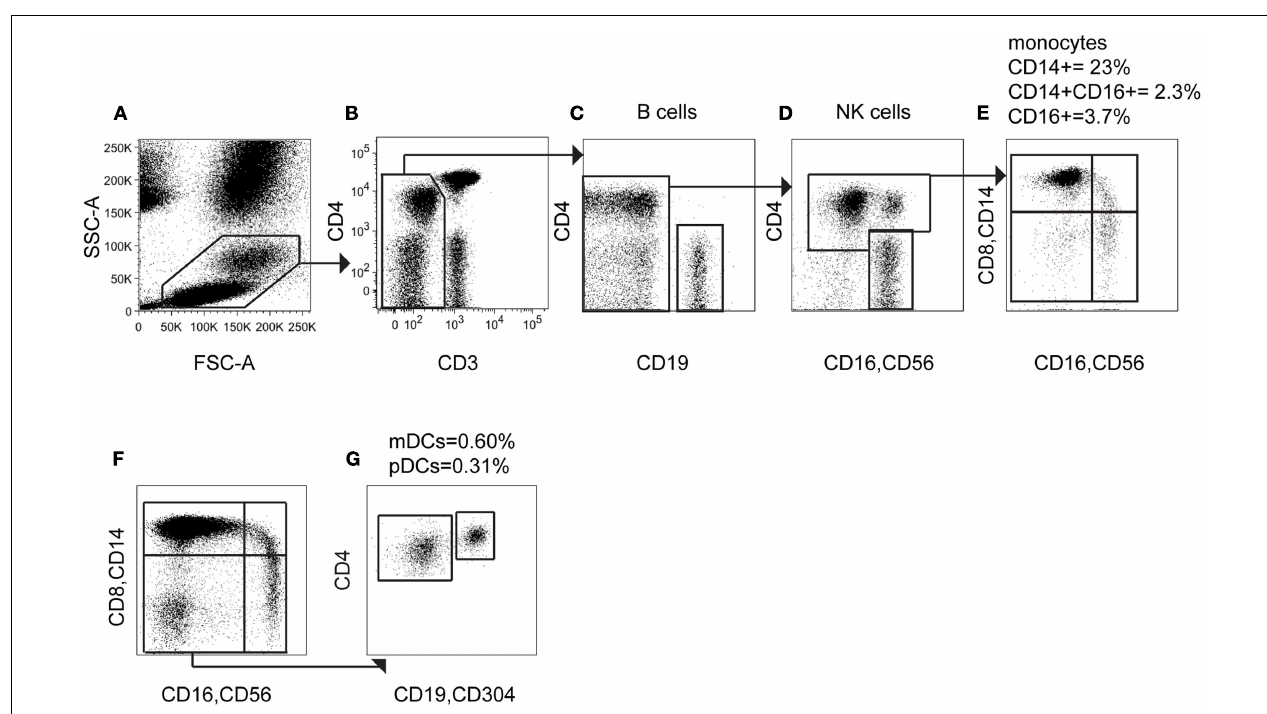
population. (D) CD16 + CD56 + NK cells are removed from analysis and the CD4 + population selected. (E) Visualized on a CD14 vs. CD16 plot, the CD4 + population contains three subsets of monocytes and CD14 − CD16 − DC. (F) Adding CD304 antibody to the assay allows further separation of the CD14 − CD16 − DC population into (G) CD4 + CD304 − mDCs and CD4 bright CD304 +